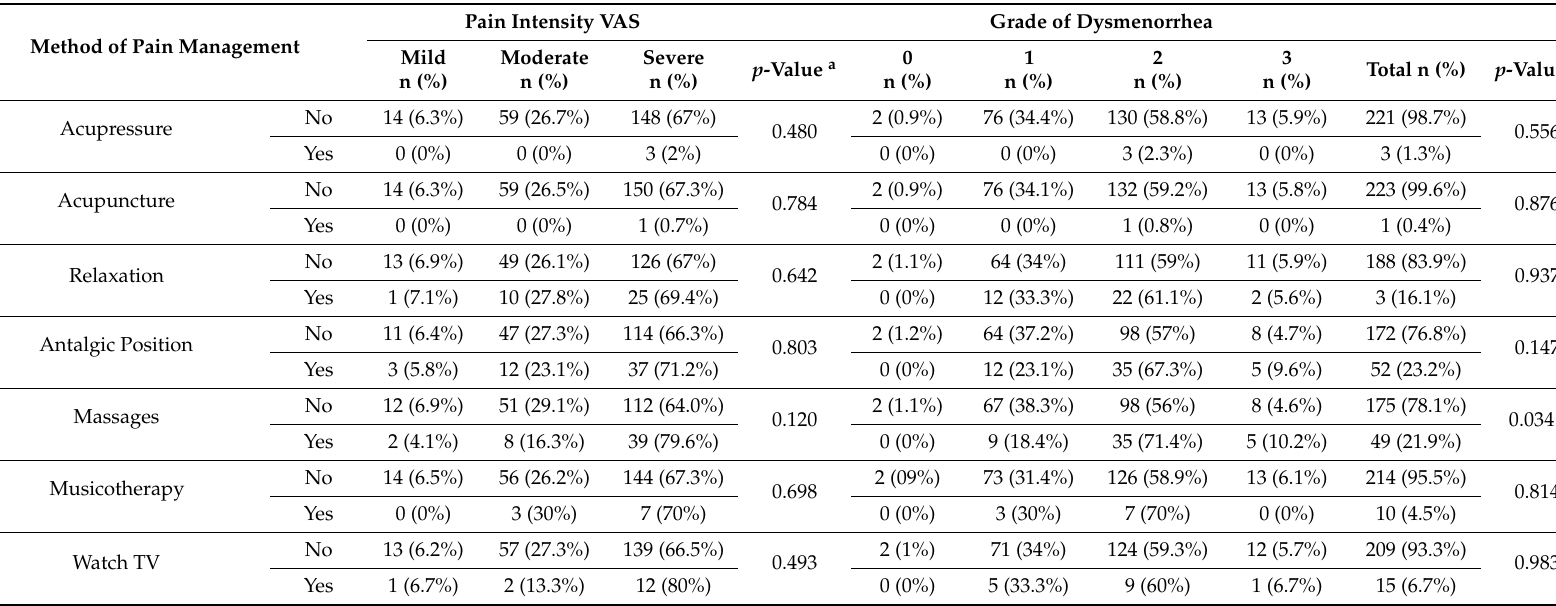
Table 3. Method of pain management chosen by women with dysmenorrhea according to pain intensity (VAS) and grade of dysmenorrhea (Andersch and Milsom scale). Method of Pain